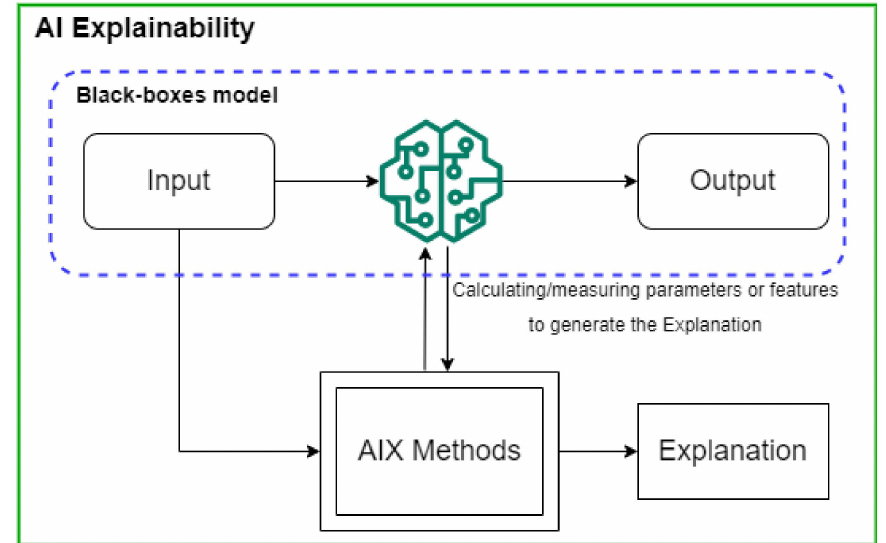
Figure 12. General overview of AI